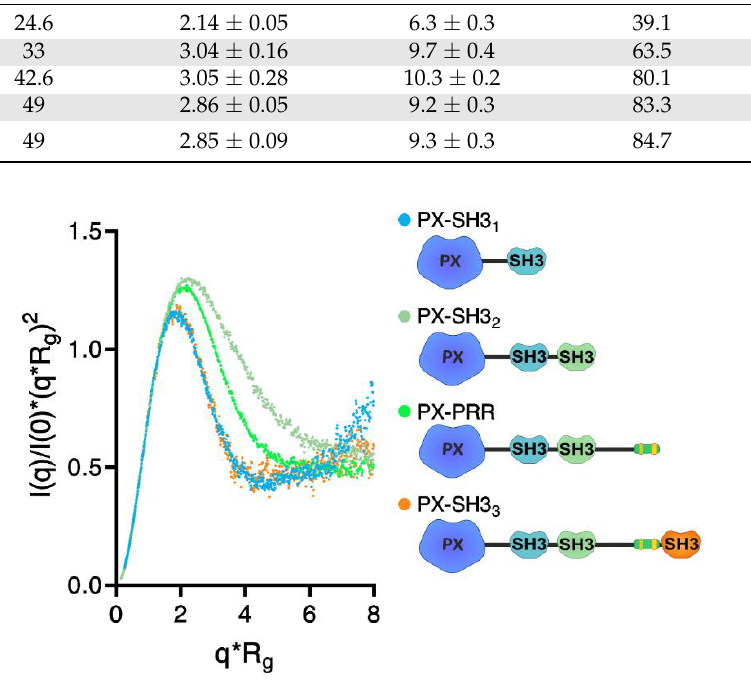
Figure 5. Normalized Kratky plot of the Tks4 constructs. The bell-shaped profiles of PX–SH3 1 and